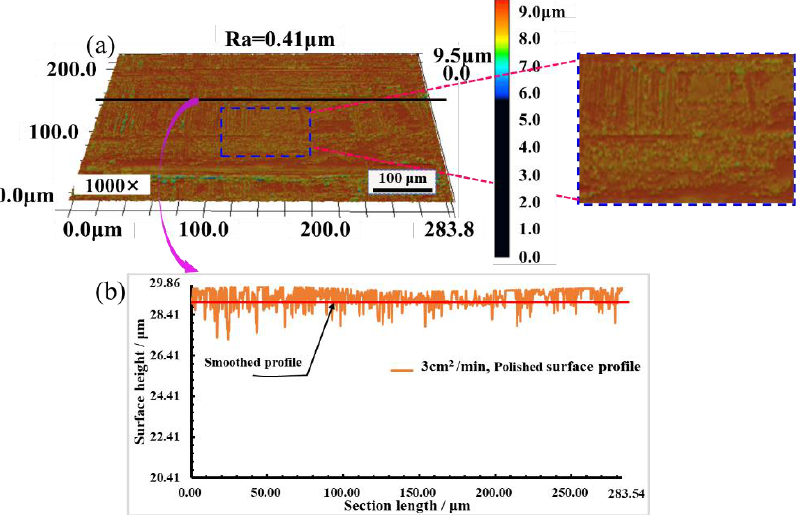
Figure 18. Surface morphology and profile with SPS N of 3 cm 2 /min. ( a ) Surface morphology; ( b ) Surface profile. ( b ) Surface